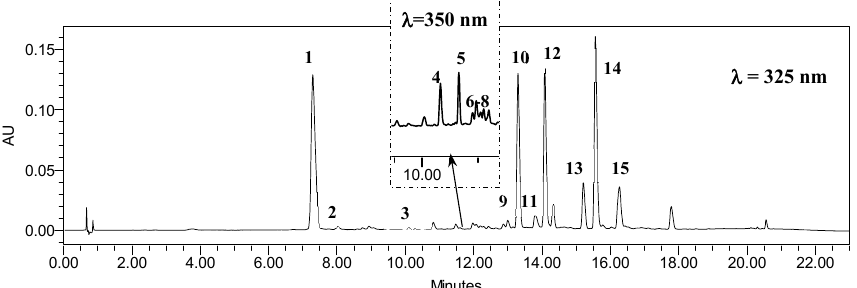
Figure 8. Representative HPLC-UV chromatogram of R. carthamoides transformed root extract recorded at 325 nm and 350 nm; 1 : 5- O -caffeoylquinic acid (5-CQA, CHA, chlorogenic acid); 2 : 4- O -caffeoylquinic acid (4-CQA); 3: 1,3-di- O -caffeoylquinic acid (1,3-diCQA); 4 : quarcetagetin hexoside; 5, 6 : quercetin hexosides; 7 : luteolin hexoside; 8 : patuletin hexoside; 9 : 3,4-di- O -caffeoylquinic acid (3,4-diCQA); 10 : 3,5-di- O -caffeoylquinic acid (3,5-diCQA); 11 : 1,5-di- O -caffeoylquinic acid (1,5-diCQA); 12 : 4,5-di- O -caffeoylquinic acid (4,5-diCQA); 13 : 1,4,5- O -tricaffeoylquinic acid (1,4,5-triCQA); 14, 15 : tricaffeoylquinic acid derivatives.